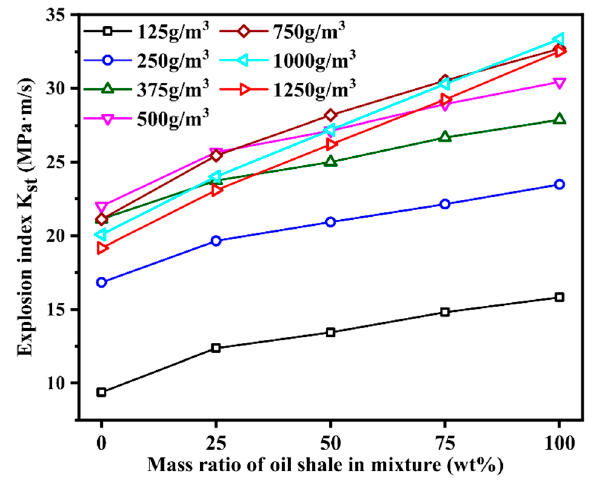
Figure 8. K St of the dust cloud versus percentage of oil shale in the mixture under different concentrations.